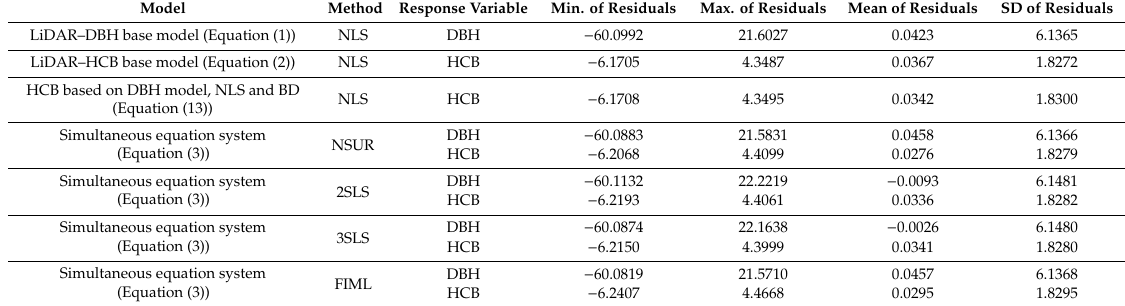
Table 4. Descriptive statistics of residuals of the LiDAR– DBH base model (Equation (1)), LiDAR–HCB base model (Equation (2)), and model (Equation (13)), and simultaneous equation system (Equation (3)). The first three models were estimated using ordinary least squares regression and last one was estimated using NSUR, 2SLS, 3SLS, and FIML. (SD, standard